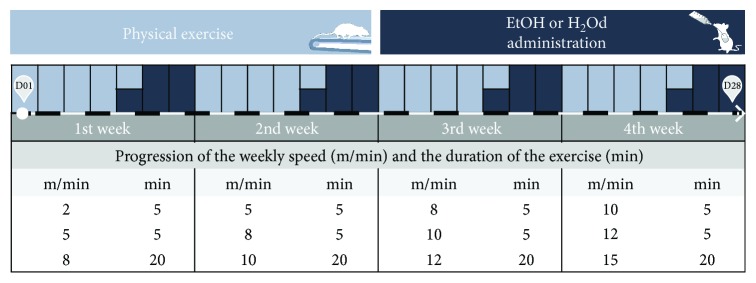
Experimental design of the treadmill physical exercise protocol and ethanol (EtOH) or distilled water (H2Od) administration by intragastric gavage since day 1 (D01) to day 28 (D28). The physical exercise protocol was adapted from Arida et al. [18].